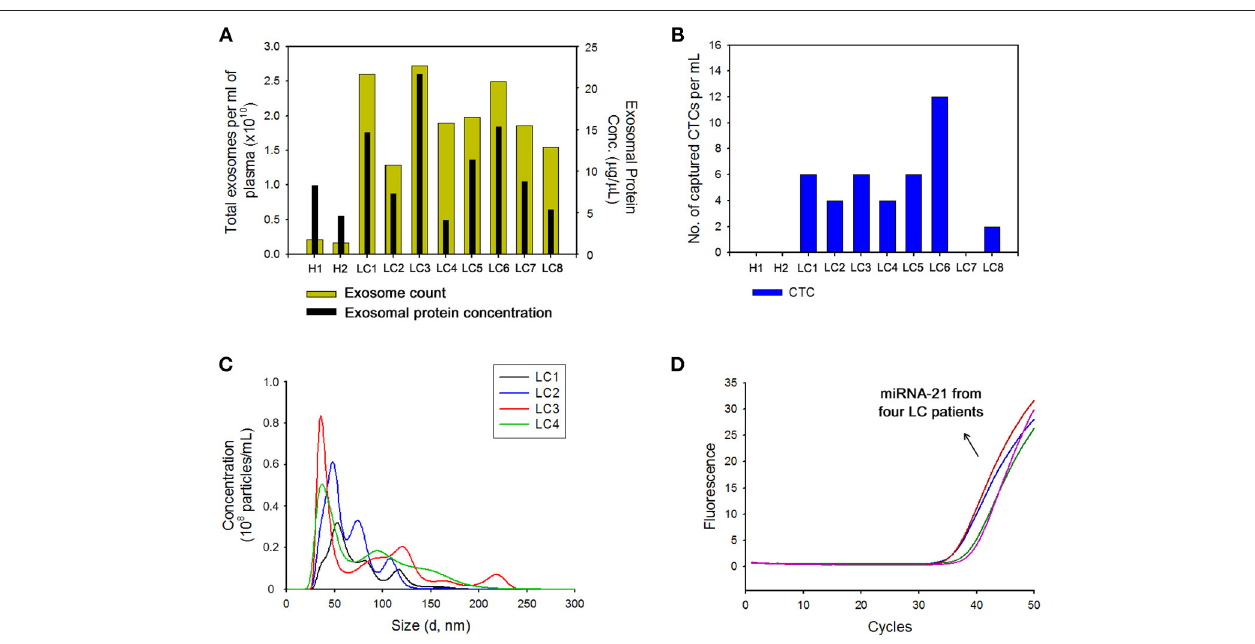
FIGURE 5 | (A) Nanoparticle tracking analysis results showing the number of exosomes and total proteins in exosomes collected from the plasma of healthy donors (H) and patients with lung cancer (LC) using the nanowire platform. (B) Evaluation of circulating tumor cells (CTCs) capture efficiency from the plasma of healthy donors (H) and patients with lung cancer (LC) using nanowire platform. (C) The size distribution of exosomes isolated with the nanowire platform from the plasma of 4 LC patients. (D) Reverse transcription-polymerase chain reaction result showing the expression levels of miR-21 in exosomes isolated from the plasma of LC patients with the nanowire